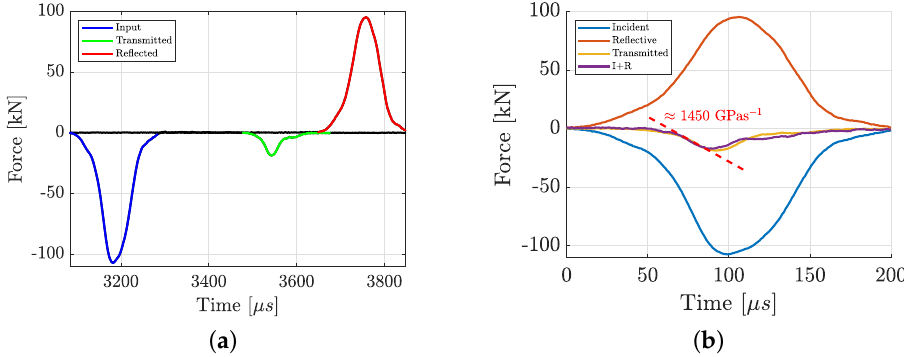
Figure 4. Representative pulses from the dynamic Brazilian disc test of granite, which is representative for all the tests conducted in this study. The incident, transmitted and reflective force waves ( a ) and the validation of force equilibrium in the sample by comparing the pulses ( b ).